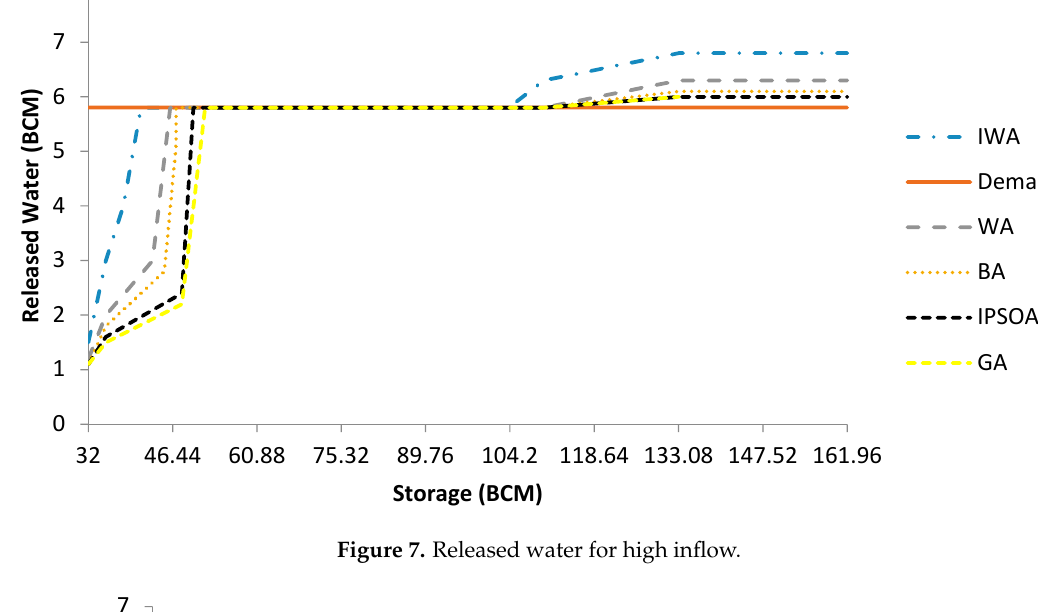
Figure 7. Released water for high inflow.